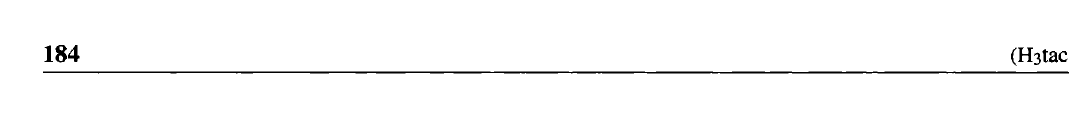
Table 1. Data collection and handling.